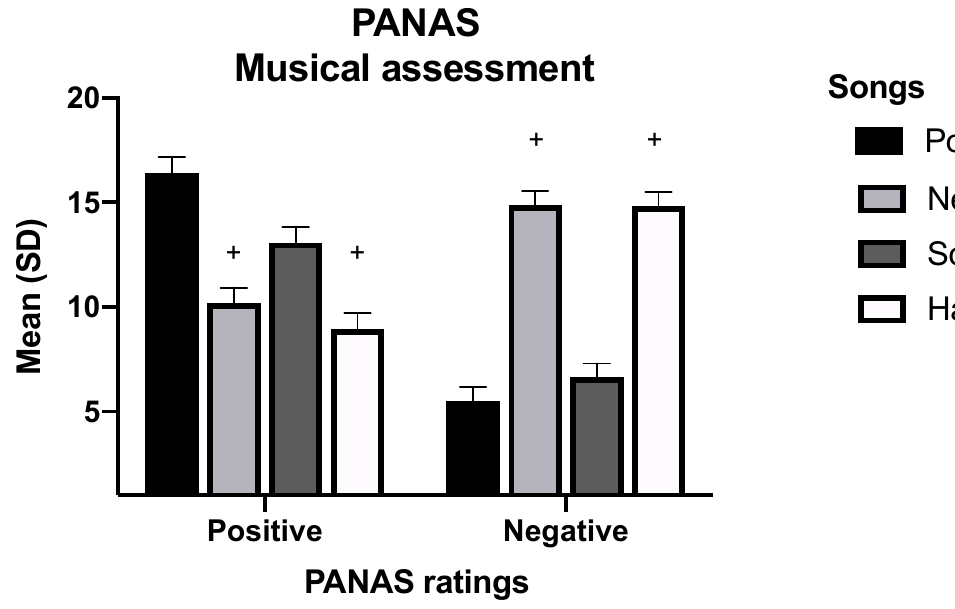
Figure A2. Summary of the Positive and Negative Affect Schedule (PANAS) ratings during the pre-test of the songs. Bars represent the mean values with corresponding standard deviations (SD). Plus signs show the only pairs of bars where there was no significant difference between such means at 95% confidence.